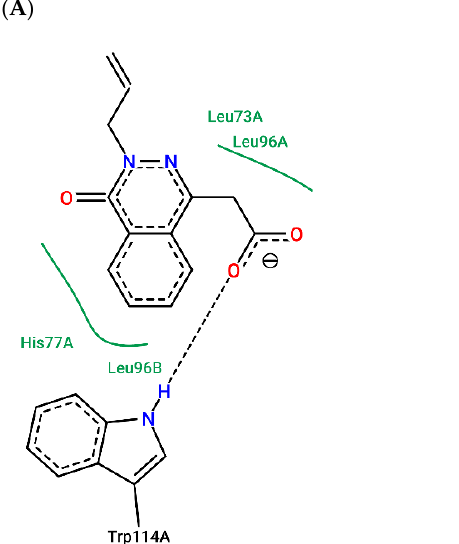
Figure 3. ( A ) Interaction map of ZINC141 in the Poseview software generated by the Aaeg OBP1 binding site (ChemPLP = 38.88). ( B ) ZINC141 superimposed on the AaegOBP1 pharmacophore model (QFIT = 85.00). Cyan spheres represent hydrophobic centers (HY) and green spheres represent hydrogen bond donors (HBD). The size of the spheres varies according to the radius tolerance calculated by GALAHAD™. All distances were measured in angstroms. (Legend: Ligand: Carbons are represented in green, nitrogen in blue and oxygen in red).